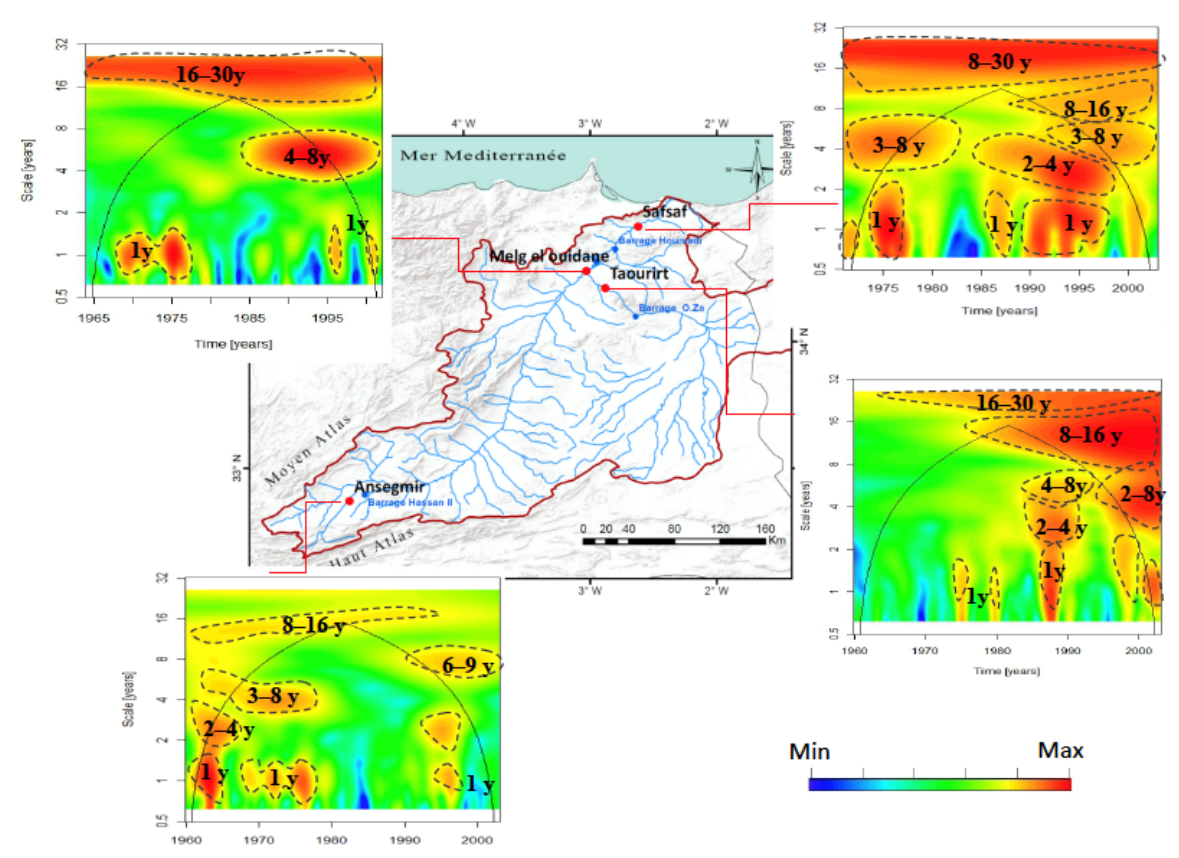
Figure 9. Study of hydrological variability in the Moulouya basin.